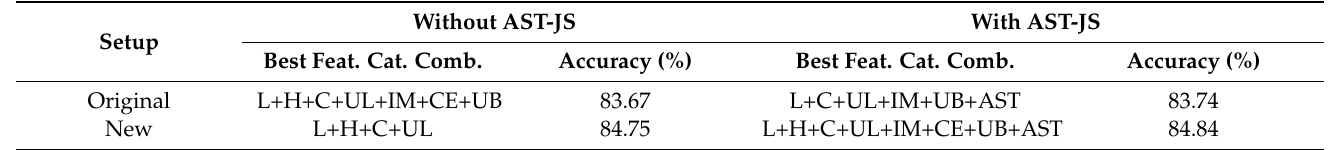
Table 4. Overall performance of proposed method with and without AST-JS. Without Setup